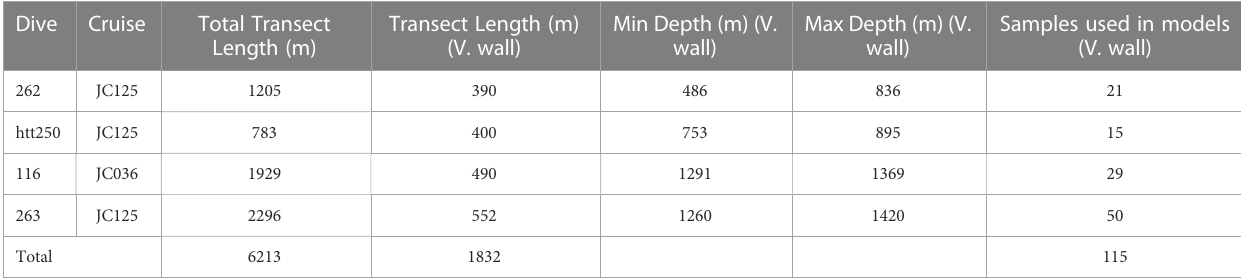
TABLE 2 Characteristics of ROV dives in Whittard Canyon analysed in the study: Cruise number, total transect length (m), transect length (m) coincident with vertical walls, maximum and minimum water depth (m) coincident with vertical walls and number of samples extracted from each dive that represent vertical